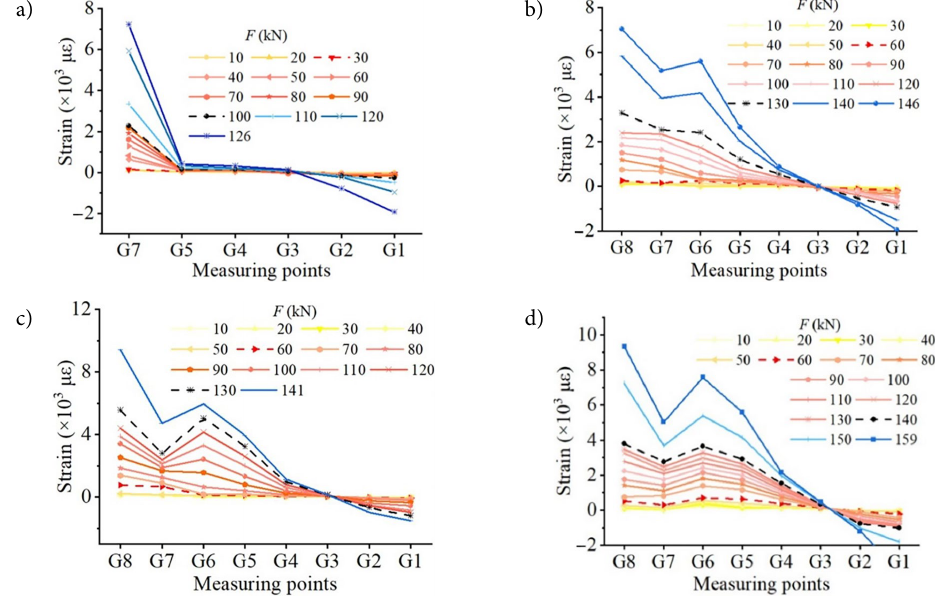
Figure 14. Strain of mid-span cross section in different experimental beams: a – Experimental beam numbered BB0; b – Experimental beam numbered BB2; c – Experimental beam numbered BB4; d – Experimental beam